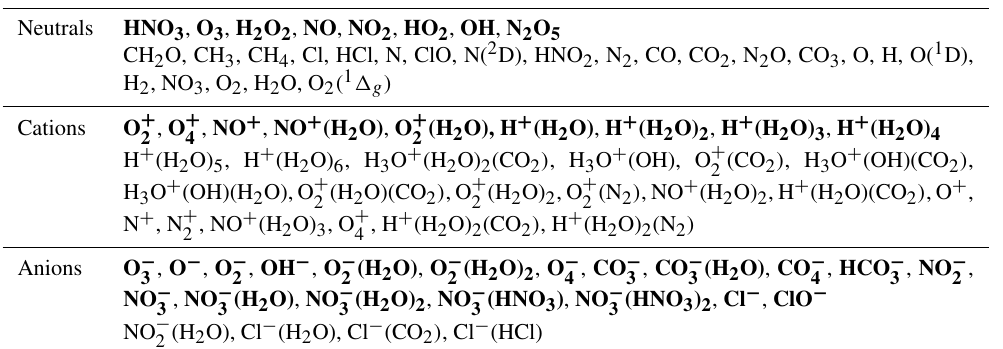
Table 1. Species of the rSIC model. The set of important species for which the concentrations are required to be reproduced within 5% rms is shown in bold type; the rest are necessary species.